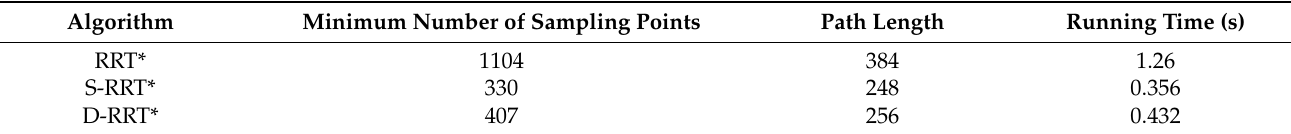
Table 2. Comparison of the three algorithms in path planning with the same starting point.